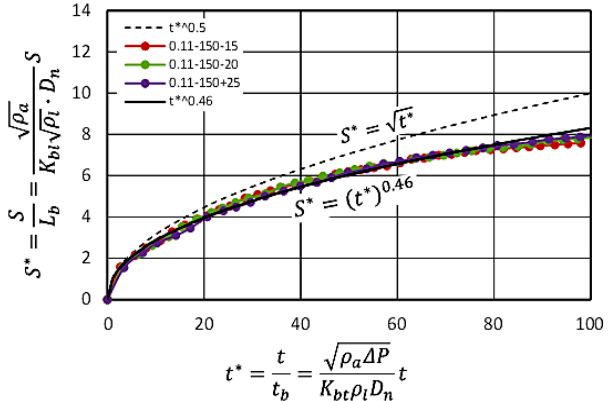
Figure 20. Normalized diesel spray penetration with 0.03 ms modification, D n = 0.260 mm, ρ a = 12 kg/m 3 (at 1.0 MPa).